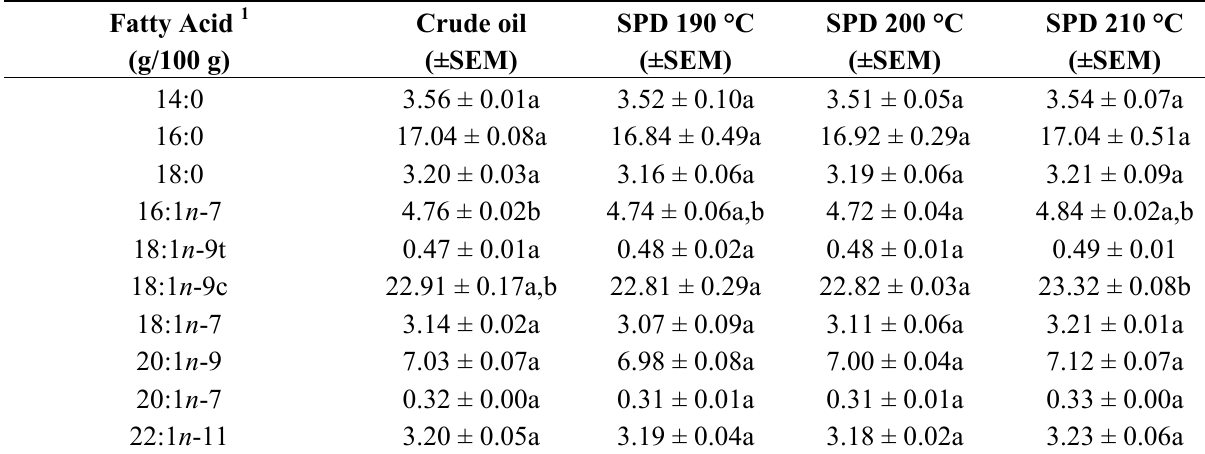
Table 2. Fatty acid (g/100 g oil) and unsaponifiable matter content of crude hoki